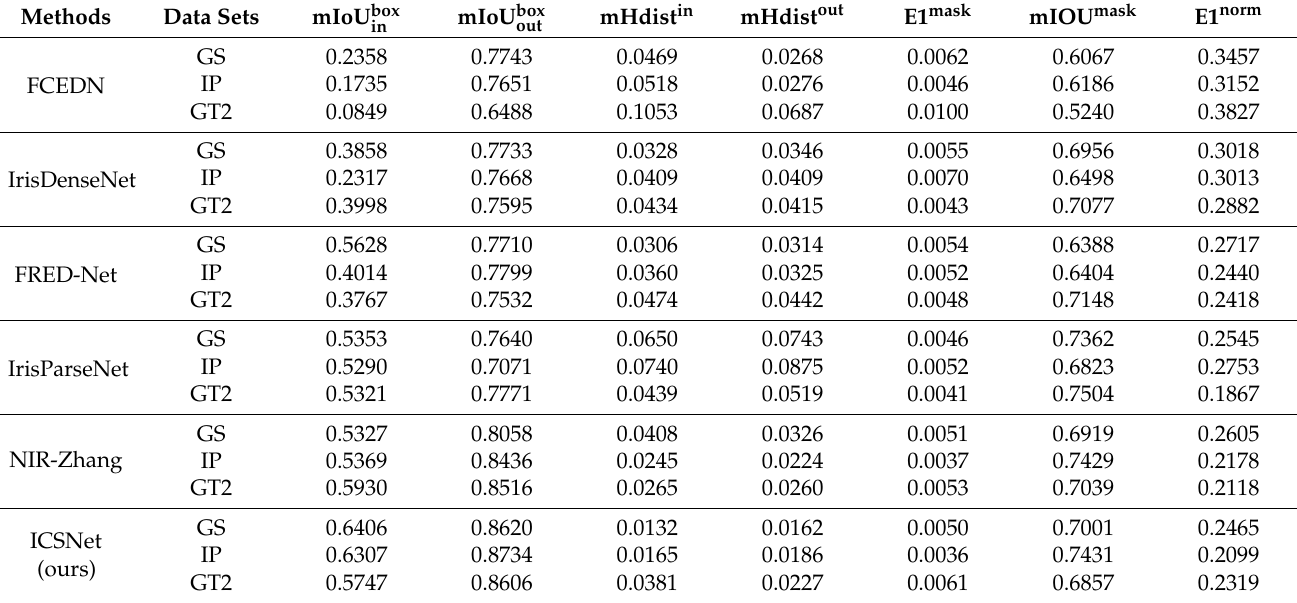
Table 3. Accuracy of iris segmentation and localization on